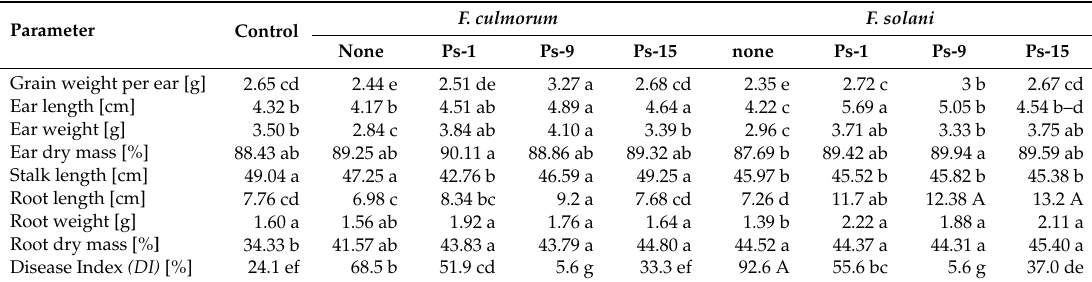
Table 3. Biometry and Disease Index ( DI ) of spring wheat plants cultivated from seeds treated with the examinedstrains(Ps-1, Ps-9, andPs-15)andinsoilinoculatedwith F.culmorum and F.solani